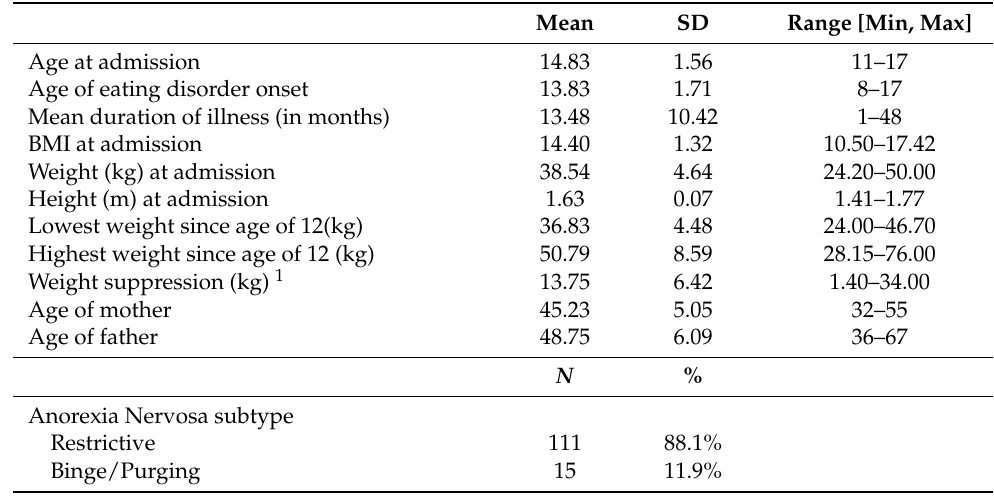
Table 1. Sample description of female anorexia nervosa patients at admission (N =